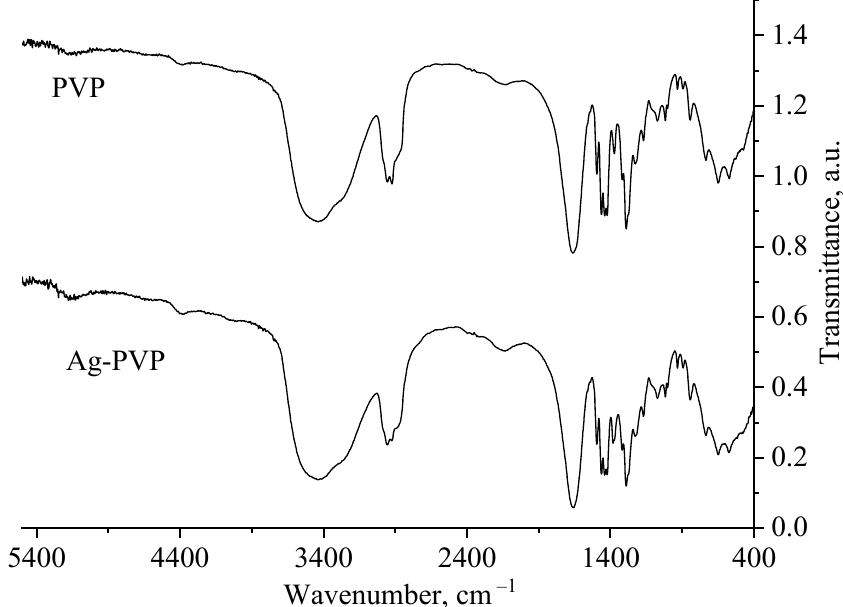
Figure 4. IR transmission spectra of PVP and a preparation of Ag NPs stabilized by PVP.